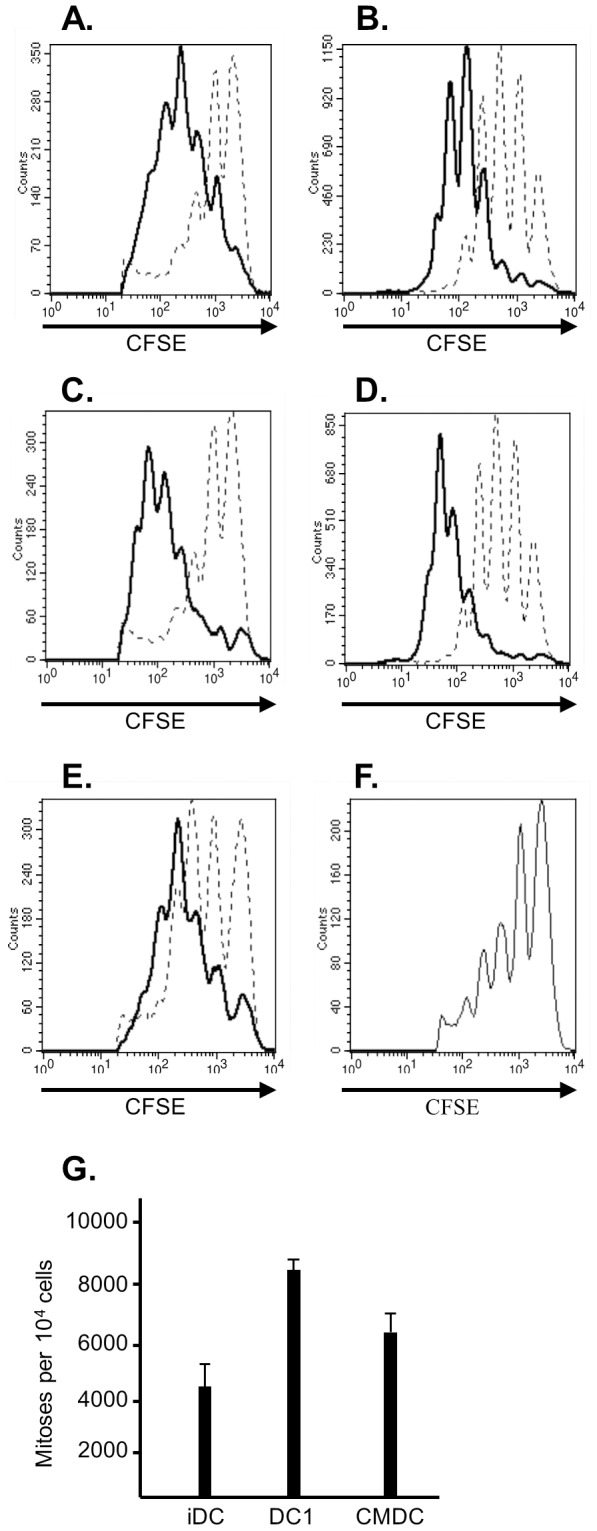
Tregs inhibit responder cell proliferation in the presence of immature but not DC1 dendritic cells.(1A&B) 2.5×105 CFSE-labeled unfractionated responder lymphocytes were initially co-cultured with 1×105 immature dendritic cells in the presence (dashed line) or absence (solid line) of 1.25×105 sorted, purified CD4+CD25+ T cells for 5 days. Responder cell proliferation is shown for CD4-gated (1A) or CD8-gated (1B) T cells. Data shown are representative of at least 10 experiments. (1C&1D) 2.5×105 CFSE-labeled unfractionated responders were co-cultured with 1.25×105 sorted CD4+CD25+ T cells and 1×105 immature (dashed line) or DC1 dendritic cells (solid line). Again responder cell proliferation is shown for CD4-gated (1C) or CD8-gated (1D) T cells. Data shown are representative of at least 10 experiments. (1E) 2.5×105 CFSE-labeled unfractionated responders were co-cultured with 1×105 dendritic cells matured using a conventional cytokine maturation cocktail (IL-1, IL-6, TNF-α, PGE-2) in the presence (dashed line) or absence (solid line) of 1.25×105 sorted CD4+CD25+ T cells. Proliferation for CD4-gated T cells is shown (N = 4). (1F) Proliferation of CD4-positive responders in the presence of Tregs and immature dendritic cells treated briefly with LPS (15 minutes) prior to co-culture is shown (N = 3). (1G) A mathematical algorithm previously applied elsewhere was used to calculate the number of mitoses per 104 responder CD4-gated T cells in the presence of iDC, DC1, or conventional cytokine maturation cocktail DC (CMDC).